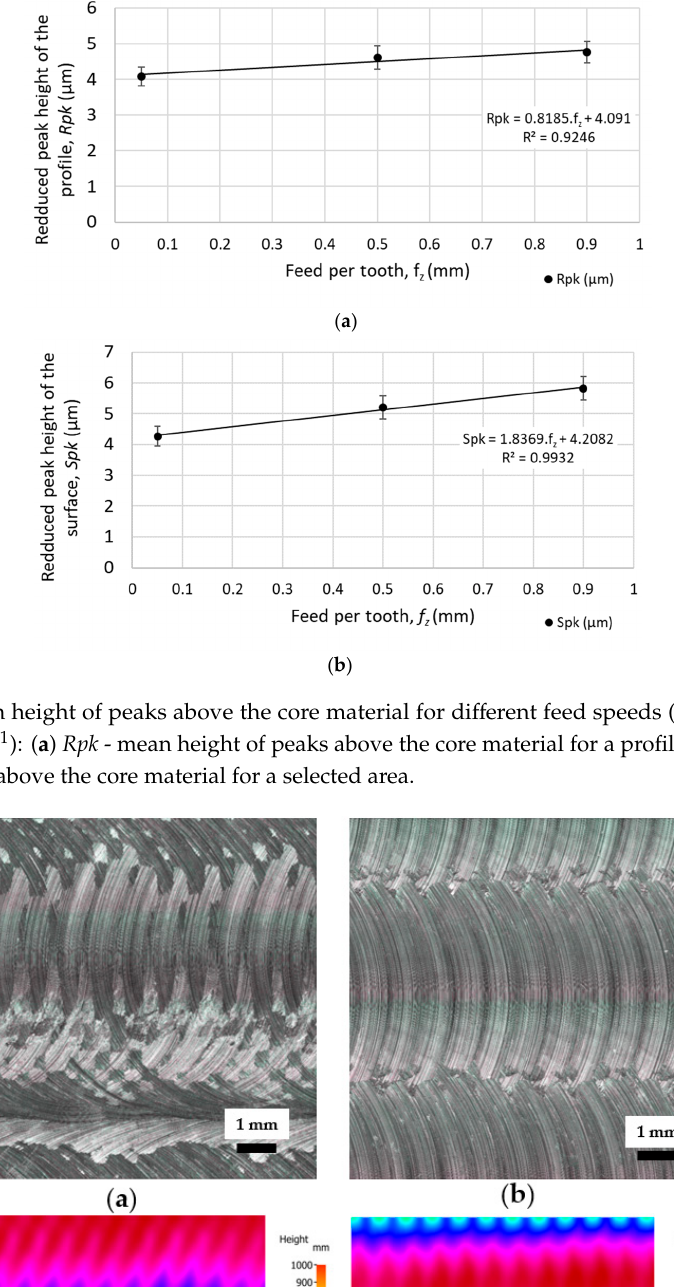
Figure 13. Mean height of peaks above the core material for different cutting speeds (at feed per tooth f z = 0.05 mm) ( a ) Rpk - mean height of peaks above the core material for a profile; ( b ) Spk - mean height of peaks above the core material for a selected area.